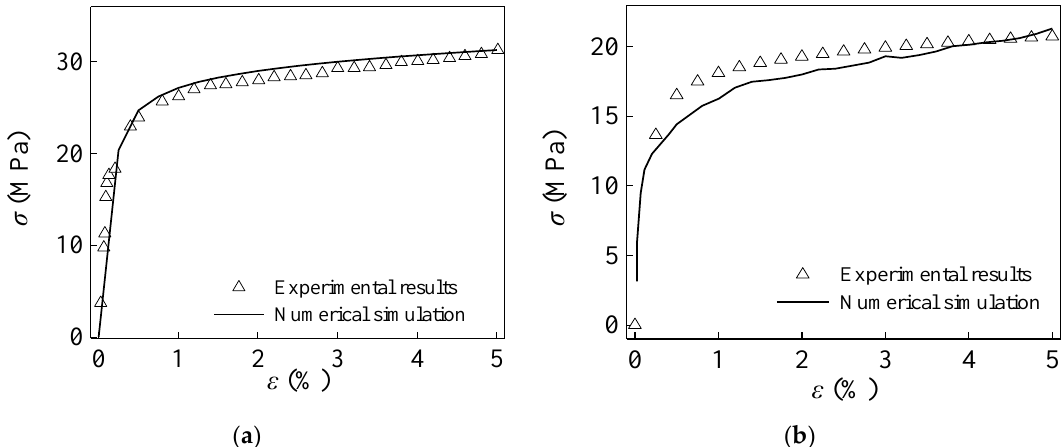
Figure 6. Comparison of the numerical results and experimental data of the 63Sn–37Pb solder: ( a ) operating temperature of 313 K and ( b ) operating temperature of 353 K. ( a ) operating temperature of 313 K and ( b ) operating temperature of 353